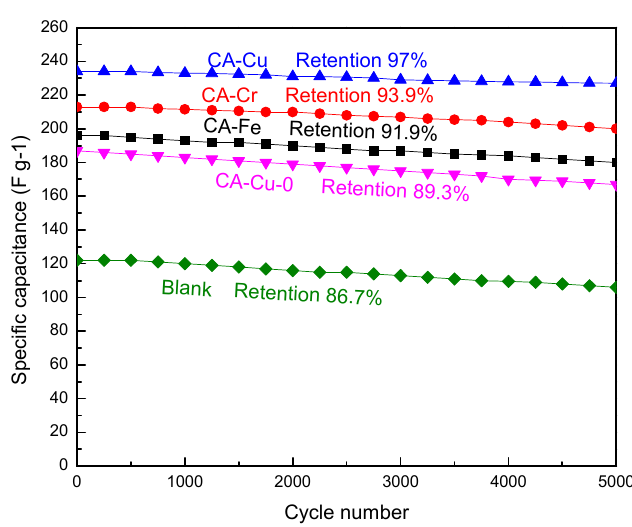
Figure 12. Charge/discharge cycles of CA-X, CA-Cu-0, and blank at the current density of 1.5 A · g − 1.